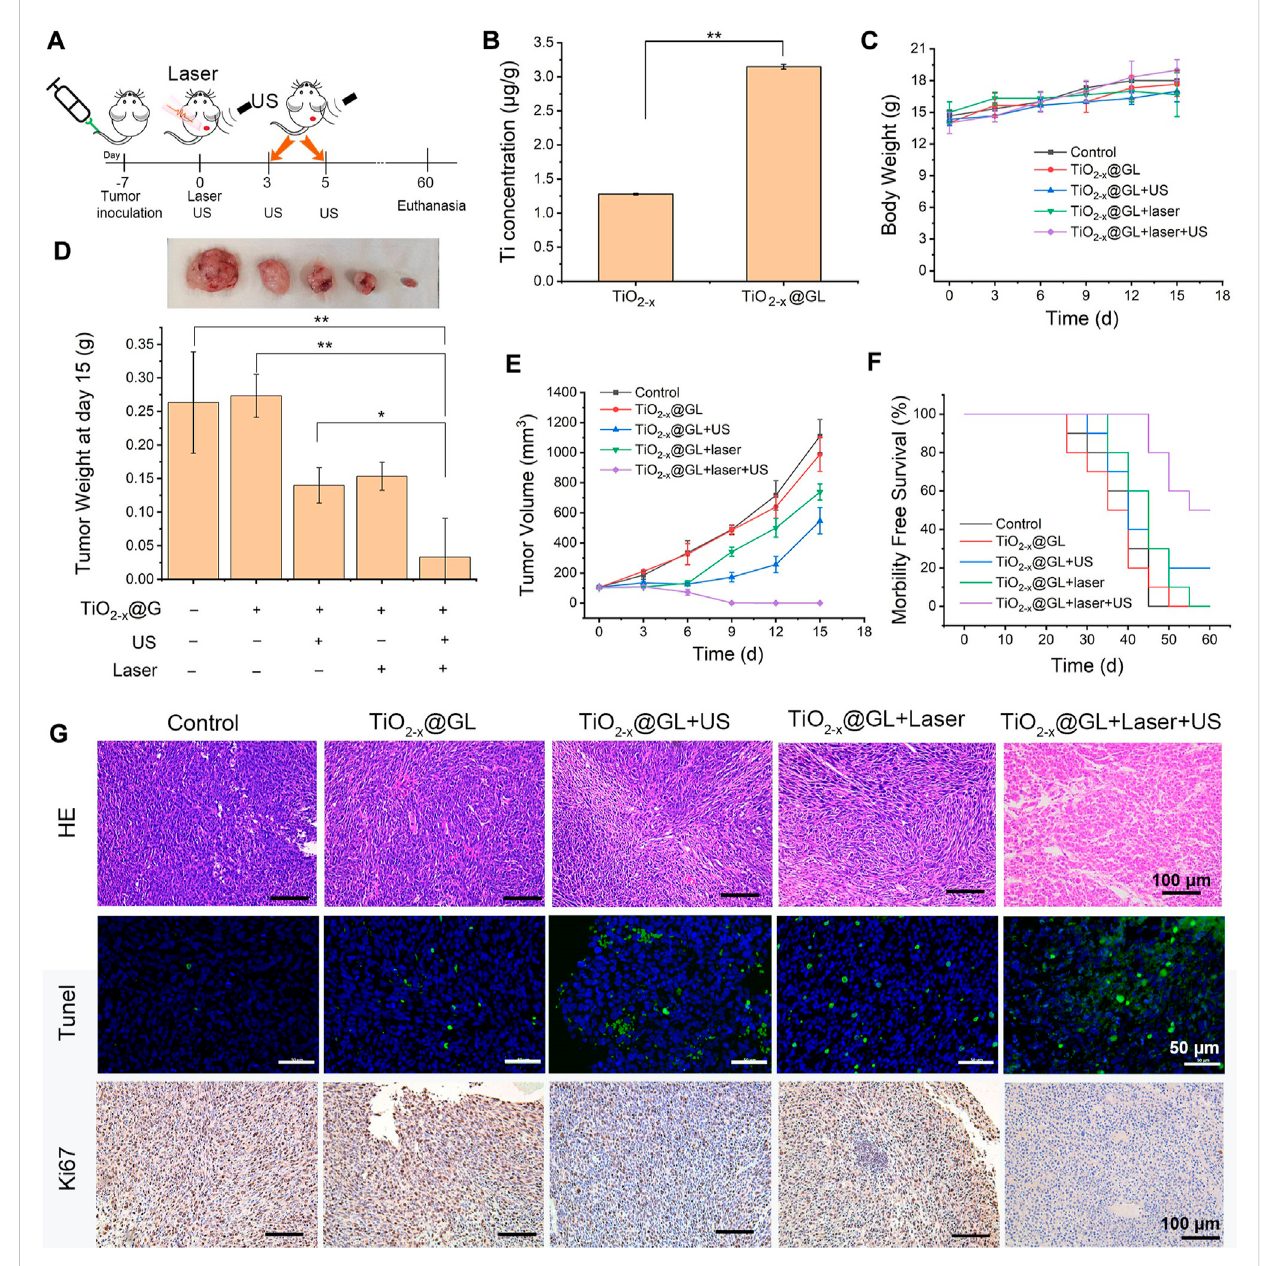
FIGURE 5 In vivo synergistic SDT/PTT on tumor suppression in the NIR-II biowindow. (A) Schematic of synergistic SDT and PTT as assisted by TiO 2-x @GL for tumor eradication. (B) Accumulated Ti in the tumor after the intravenous injection of TiO 2 − x or TiO 2 − x @GL for 4 h. (C) Time-dependent body-weight curves of 4T1 tumor-bearing mice in groups of control group, TiO 2-x @GL group, TiO 2 − x @GL combined with US group, TiO 2 − x @GL combined with laser group and TiO 2 − x @GL combined with the laser and US therapy group. (D) Tumor weight of different groups on day 15. (E) Time-dependent tumor- volume curves during the 15 days. (F) Survival curves of 4T1 tumor-bearing mice after different treatments. (G) H&E staining, Tunel staining, and Antigen Ki-67 immunohistochemistry staining in tumor region of each group after the treatments. * p < 0.05, ** p < 0.01, and *** p <